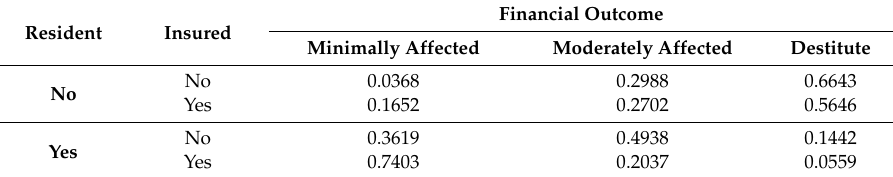
Table 3. Summary of probabilities of destitution on residency and insurance of patients.